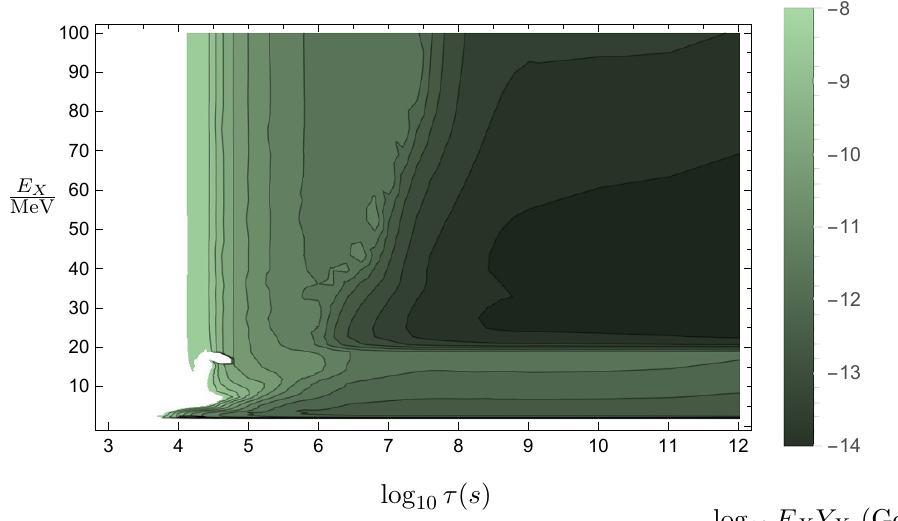
Figure 5 . Combined limits on E X Y X as a function of (cid:28) X and E X for the decay of a species X with lifetime (cid:28) X injecting a single photon with energy E X .